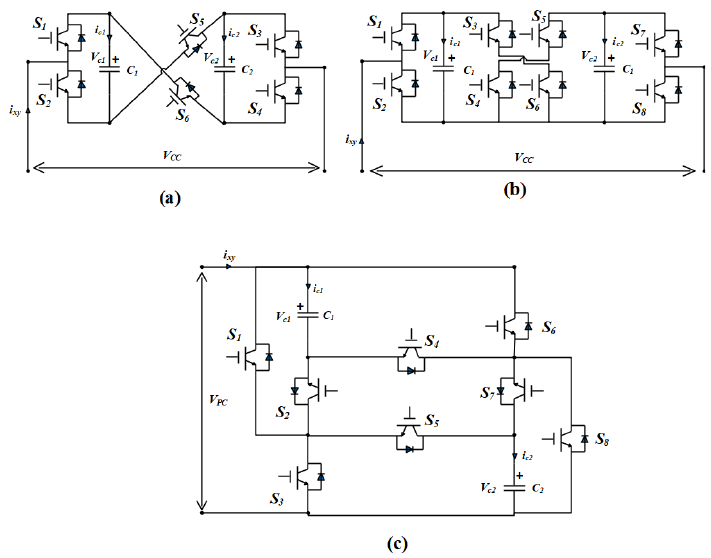
Figure 5. Five-level submodule variants ( a ) Five-Level Cross-Connected SM(FLCCSM), ( b ) Cross-Connected SM(CCSM), ( c ) Parallel-Connected SM. Table 1. Comparison of different submodules [13 – 20] .